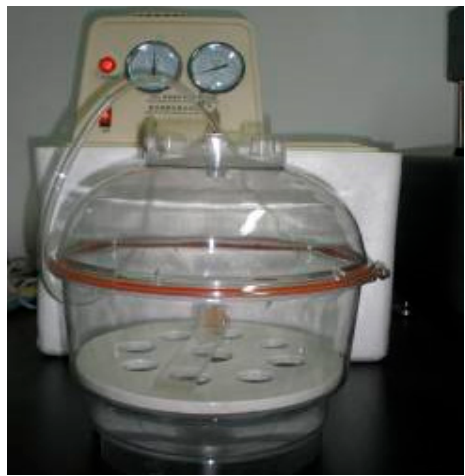
Figure 3. Specimen in a vacuum pump.